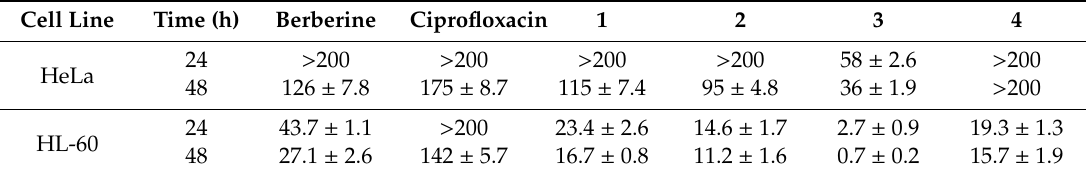
Table 2. IC 50 values ( µ M) for antiproliferative activity of berberine, ciprofloxacin and berberine derivatives 1 – 4 determined by MTT